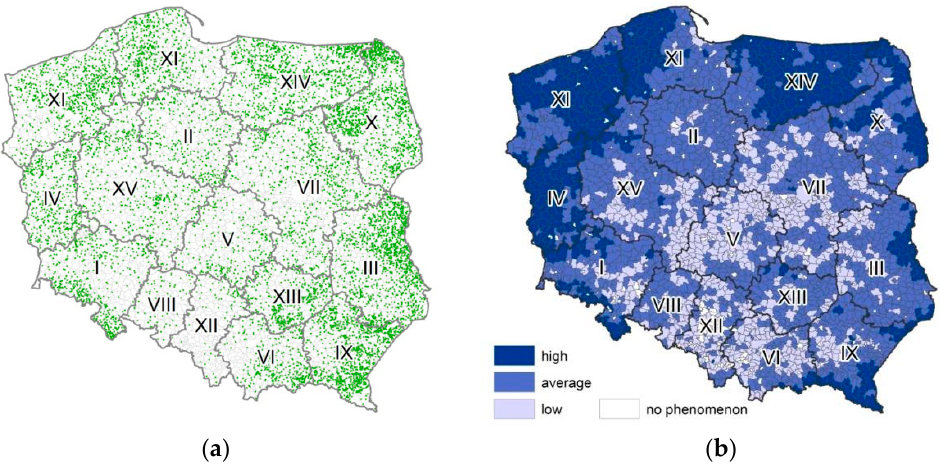
Figure 2. Number of submitted applications ( a ) and the synthetic indicator of the utilisation of the Rural Development Program (IUF-RDP-indicator for the use of proenvironmental RDP ( b )). *1 dot = 10 applications. Source: own elaboration on [66–68,70,71].